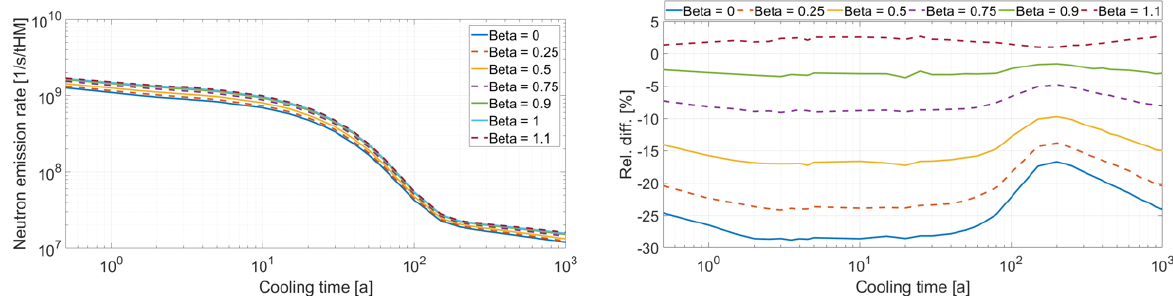
Figure 4. Neutron emission rate as a function of cooling time for different albedo boundary conditions.